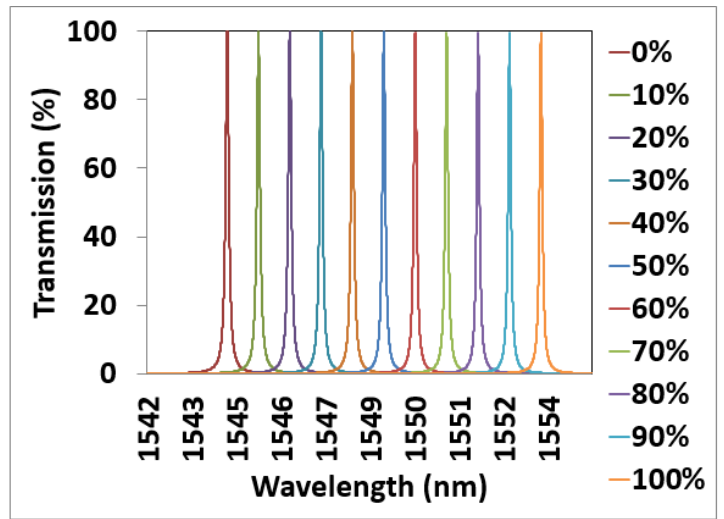
Figure 8. Optical transmittances as functions of wavelength and water temperature (°C) for a deformed photonic scheme with 50 alternated layers of fused silica and TiO 2 and with a middle cavity filled with seawater at 35% salt level.